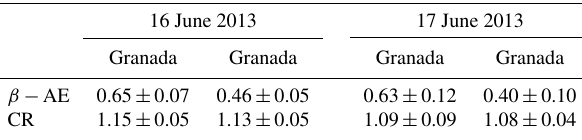
Table 5. Mean value of backscatter Ångström exponent ( β − AE) and colour ratio (CR) between 532 and 1064nm, retrieved by GRASP for dust layers on 16 and 17 June